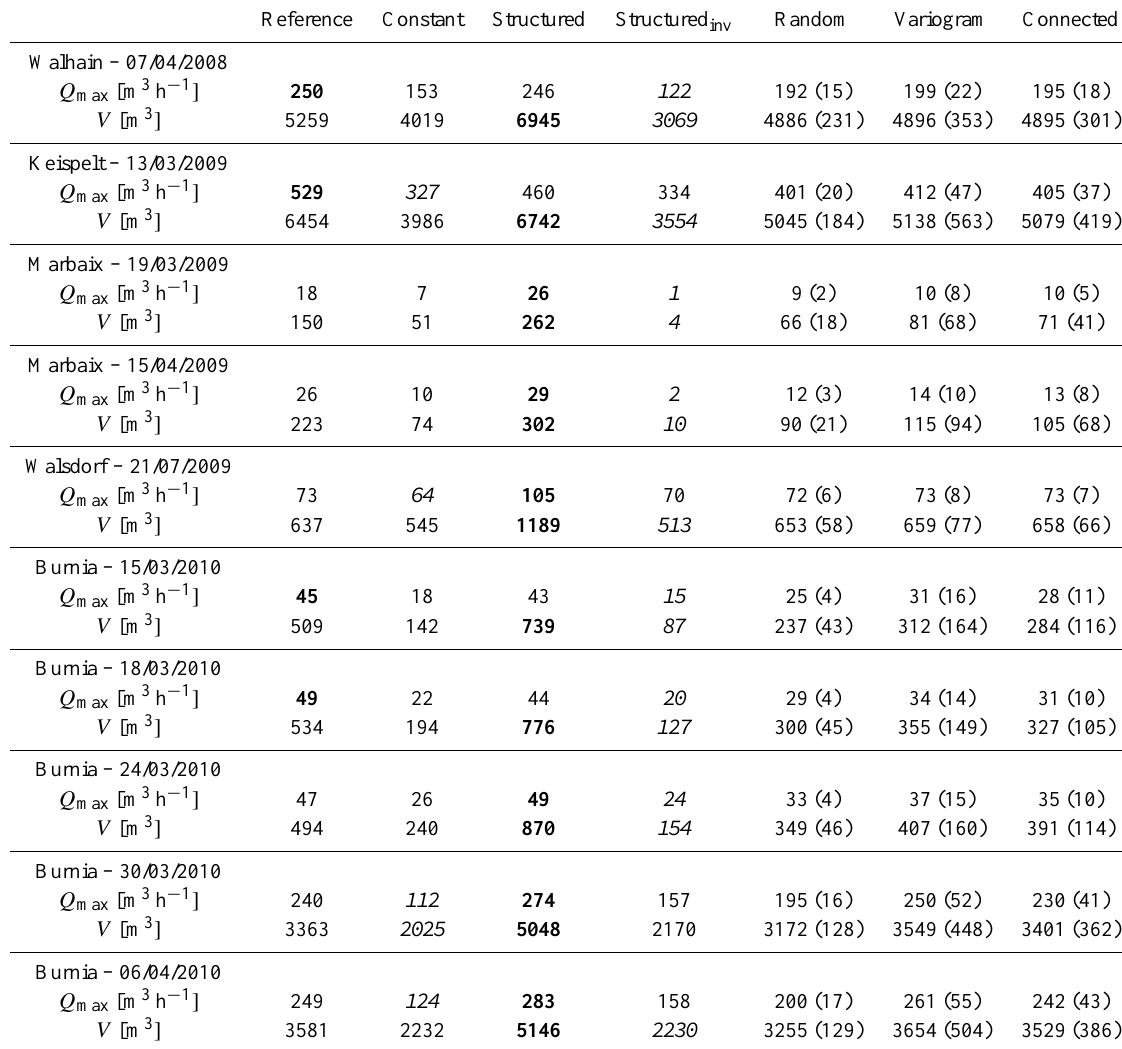
Table 3. Runoff peak Q max and total runoff volume V for each antecedent soil moisture scenario for the 10 field campaigns. For the stochastic scenarios, the average Q max and V were computed and the standard deviations are depicted in brackets. Maximum and minimum values for each field campaign are highlighted in bold and italic,